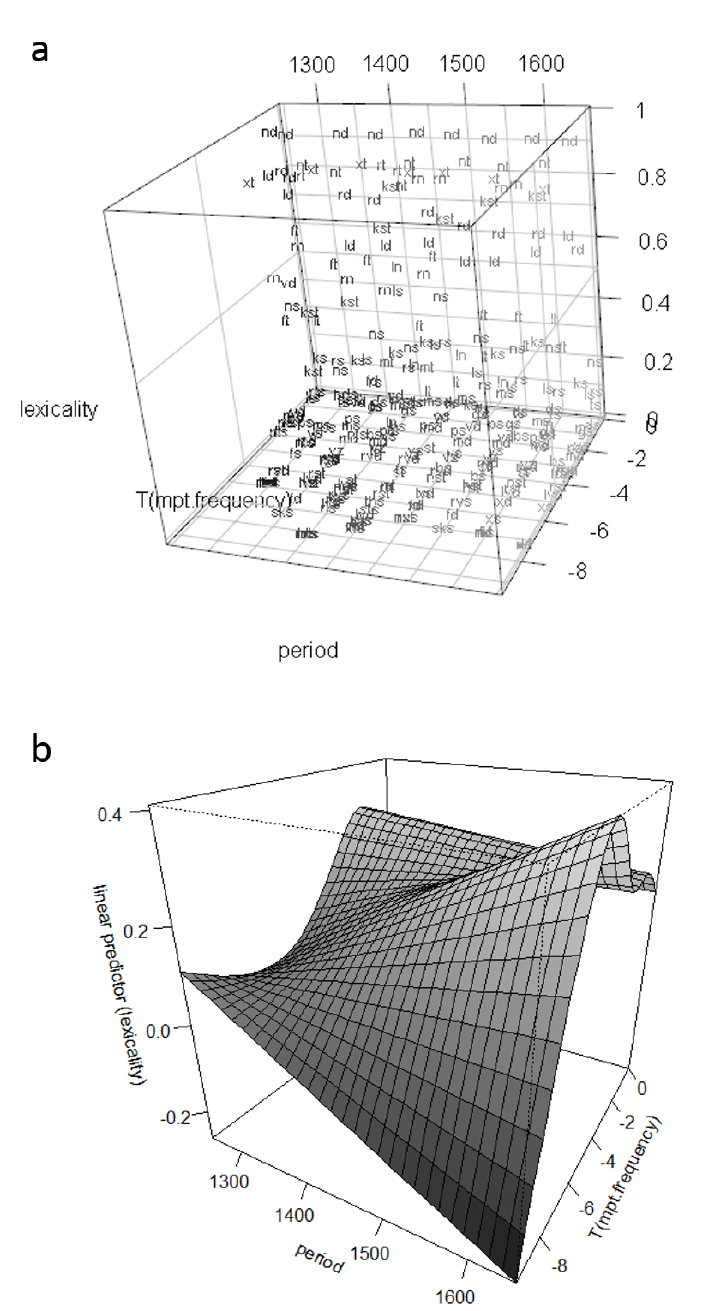
Figure 3. (a) Scatterplot showing the diachronic development of the morphonotactic space, where 𝜑 is normalized with respect to the period-­‐wise maximal scores and !"# Box-­‐Cox transformed to 𝑇 ( 𝜑 ) . (b) Plot of a generalized additive model fitted to the !"# transformed data. The impact of the morphonotactic token frequency on cluster lexicality is evidently changing over